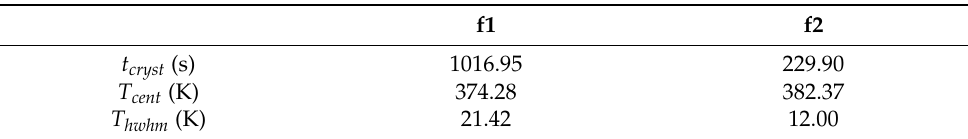
Figure 6. Fitting of a DSC curve by two TDGL functions.